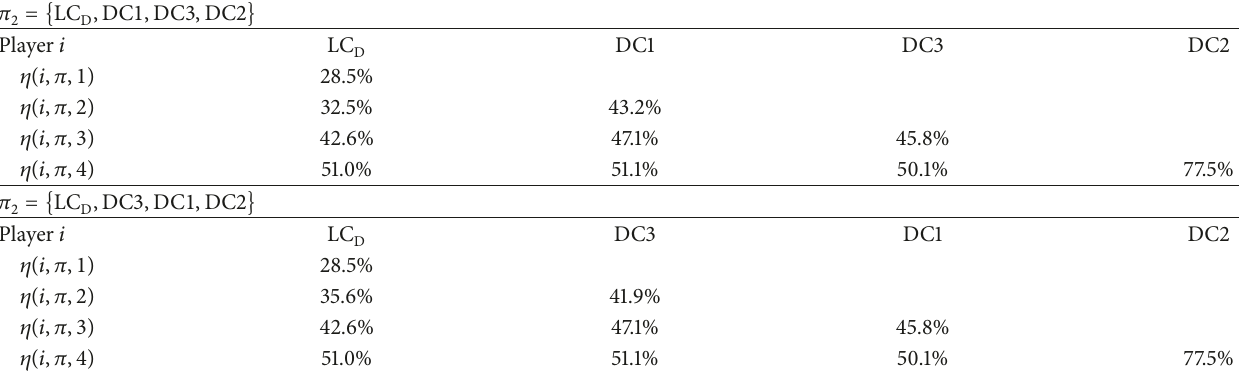
Table 12: Distribution coalition sequences based on SMP.